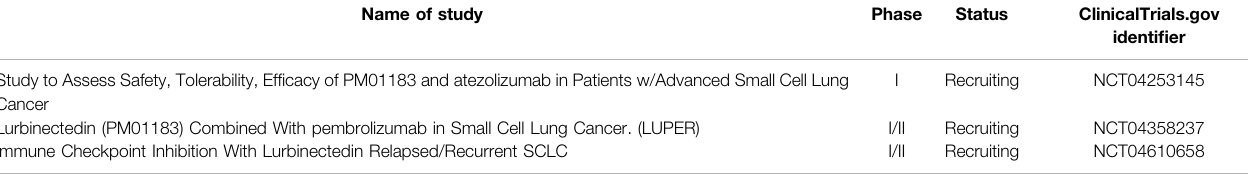
TABLE 2 | Current FDA Trials involving Lurbinectedin in SCLC